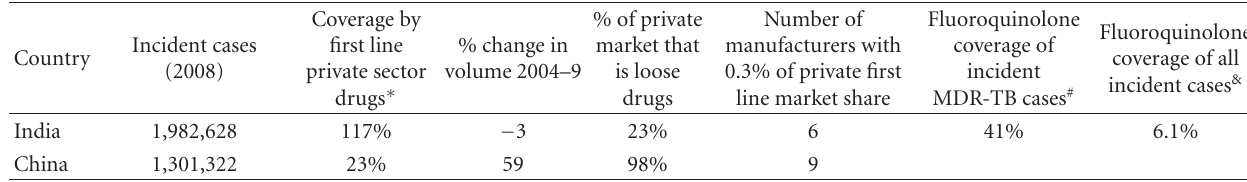
Table 2: Size and characteristics of private TB market, adapted from Wells